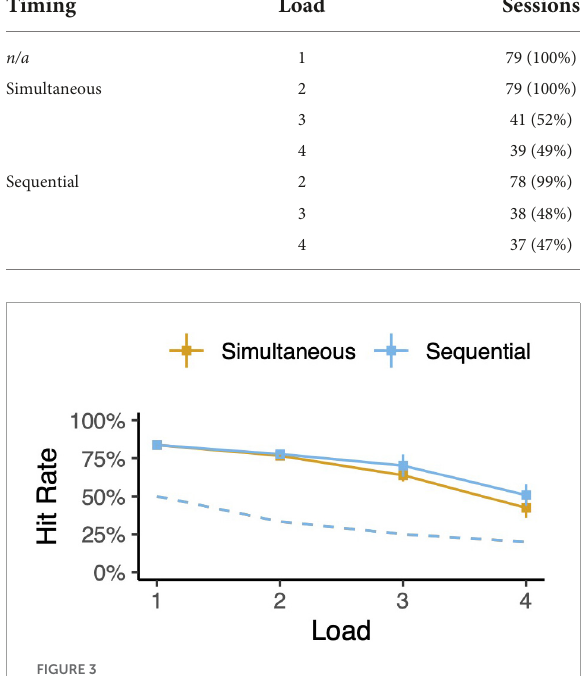
TABLE 2 Number of sessions in which Monkey H performed each trial type.